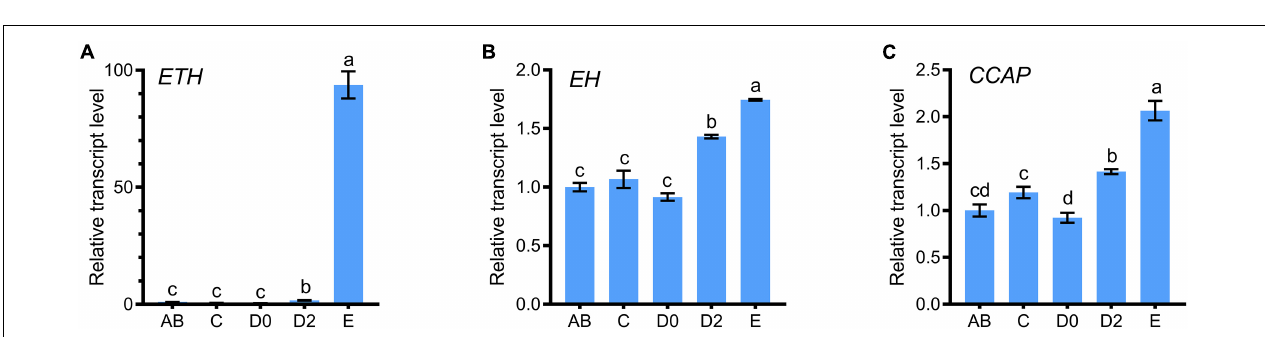
FIGURE 1 | Tissue expression patterns of ETH (A) , EH (B) , and CCAP (C) in S. paramamosain . Tissues include cerebral ganglion (CG), eyestalk (ES), thoracic ganglia (TG), hepatopancreas (HP), stomach (ST), heart (HE), gill (GI), muscle (MU), epidermis (EP), and leg (LE) of crabs at the intermolt stage. For each sample, five individuals were measured in triplicate using real-time quantitative PCR (qRT-PCR) analysis. The values were calculated using the 2– (cid:49)(cid:49) CT method. The relative transcript levels of CG were set as 1. The bars represented averages relative transcript levels and standard deviation (SD). Different letters indicated significant differences at P < 0.05 analyzed by ANOVA and the Tukey-Kramer test.